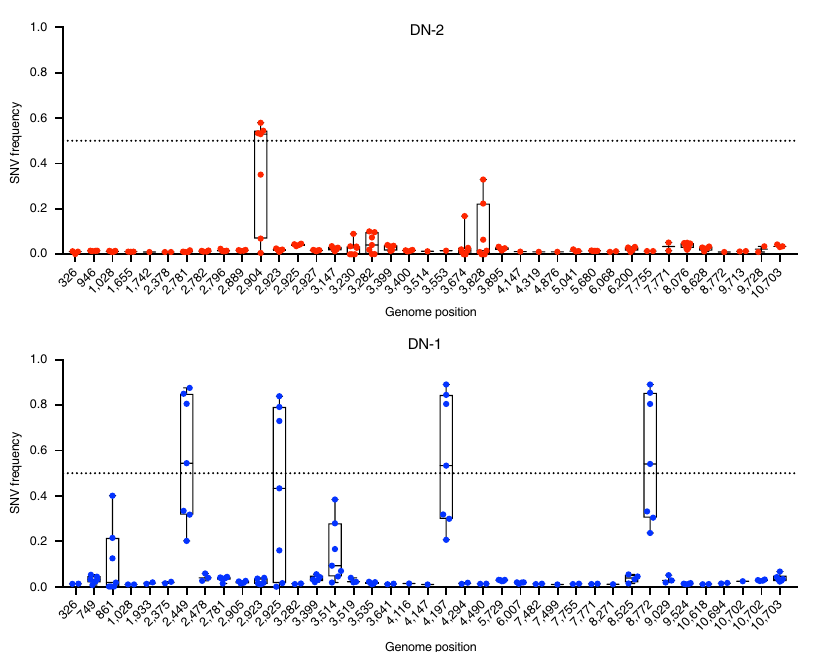
Fig. 2 Genome stability of DN-1 and DN-2 after serial passage. Whole-genome sequencing of DN-1 and DN-2 at each of seven serial passages was performed using next-generation sequencing to determine stability of the M66V mutation and identify additional mutations, if any, after each serial passage. Single-nucleotide variants (SNVs), with >0.01 (1%) frequency, at different genome positions at each serial passage are plotted to determine genome stability. Each data point represents the frequency at a serial passage. Box and whiskers plots show the range of frequencies of SNVs detected over the serial passages, with the box representing the 25th – 75th percentiles while the whiskers represent the maximum and minimum frequencies detected. Dotted line at the SNV frequency of 0.5 represents the point above which a variant is recognized as the consensus